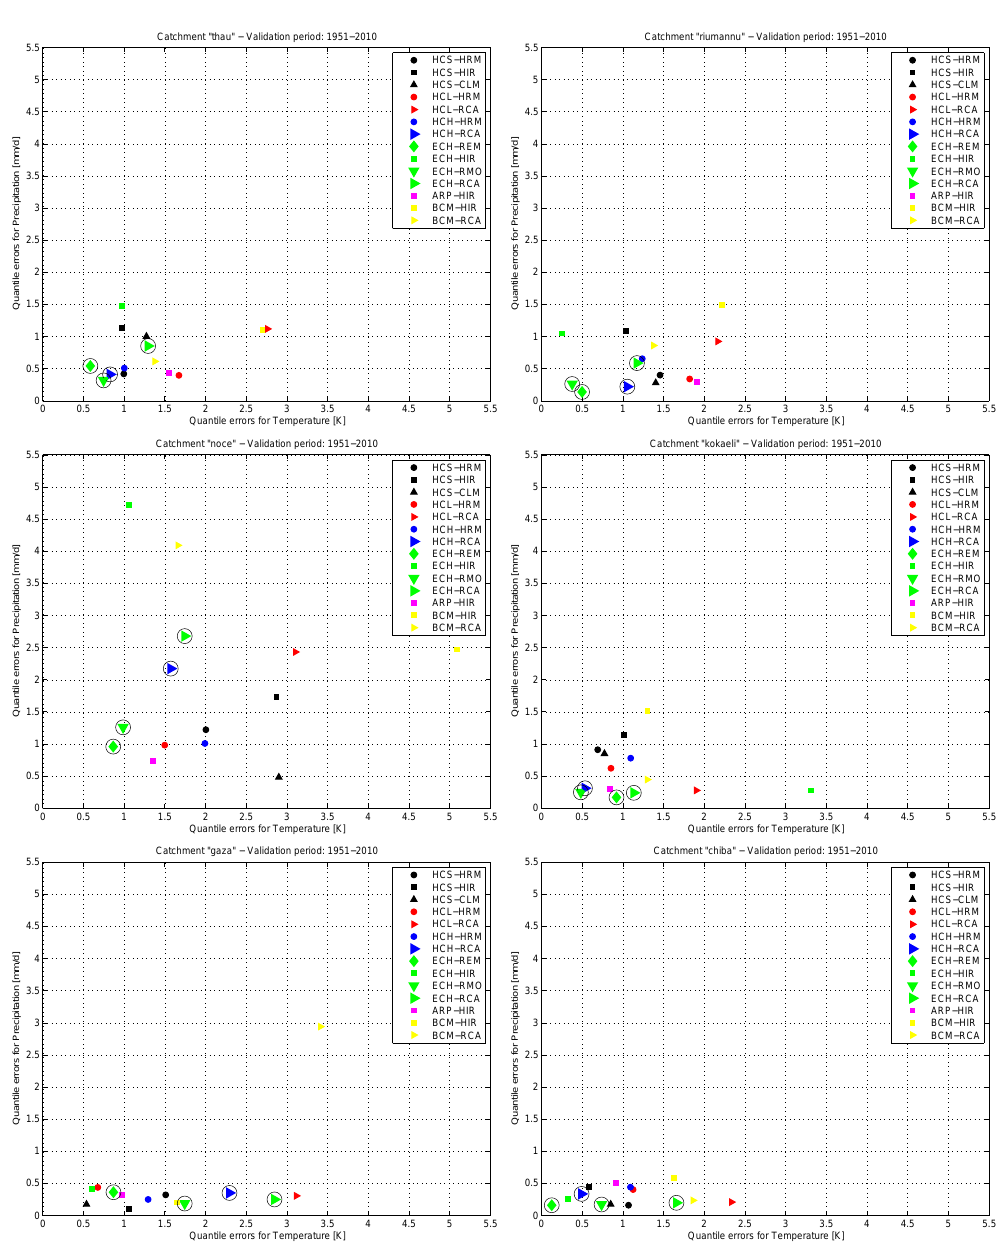
Fig. 8. Scatter plots of mean absolute errors in the quantiles of daily precipitation and temperature distributions, computed using Eq. (8) for each of the 14 ENSEMBLES models with respect to E-OBS observational reference. Quantiles are calculated at 100 uniformly spaced probability levels. Each subplot displays areal averages over a 4 × 4 grid-point stencil centered in each catchment. 27